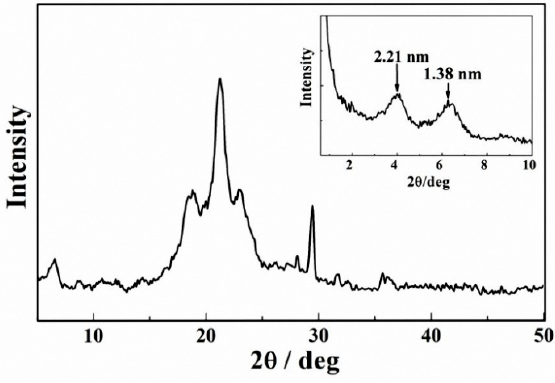
Figure 7. X-ray di ff raction pattern of the xerogel formed by compound 4 in benzene (4.0 wt%). Figure 7. X-ray diffraction pattern of the xerogel formed by compound 4 in benzene (4.0 wt%). The results indicated that due to the intermolecular interactions, the gelators rearranged and formed an orderly network structure during the self-assembly process. The low-angle X-ray di ff raction pattern of compound 4 xerogel in benzene shows periodical di ff raction peaks, which indicates compound 4 self-assembles into an ordered supramolecular structure. The XRD pattern shows the that the largest Bragg distance was 2.21 nm, which was consistent with the length (2.213 nm) reported for